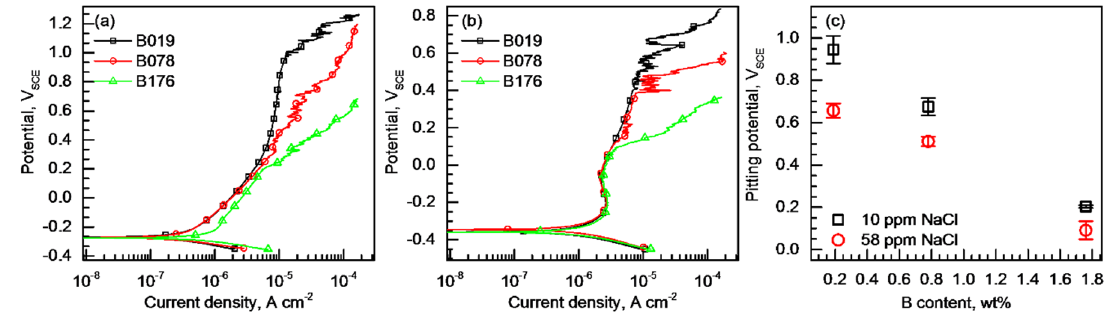
Figure 5. Potentiodynamic polarization curves of the alloys measured in ( a ) 10 ppm and ( b ) 58 ppm NaCl solutions at 20 ± 1 °C at a potential sweep rate of 2 mV s − 1 ; ( c ) Variation of the average pitting potentials of the alloys as a function of the B content.